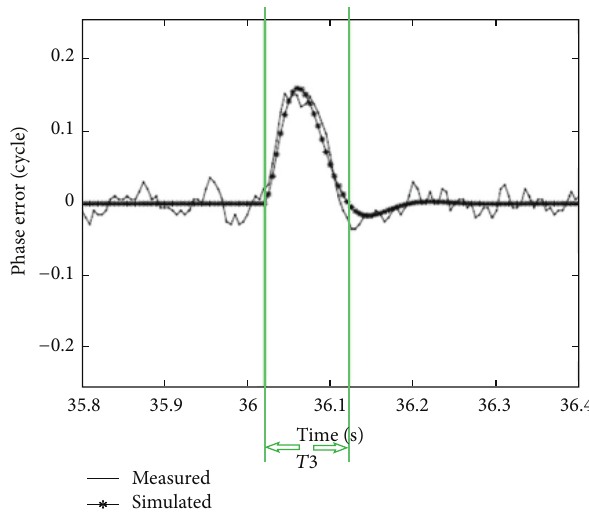
Figure 6: Phase error in